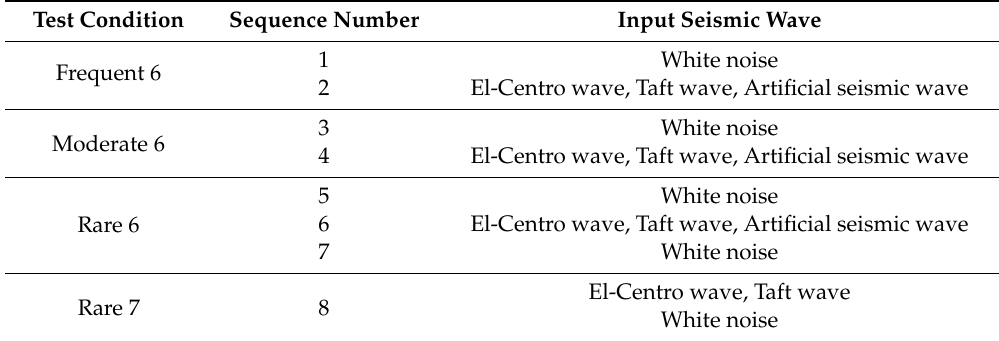
Table 5. Sequence of the shaking table test.